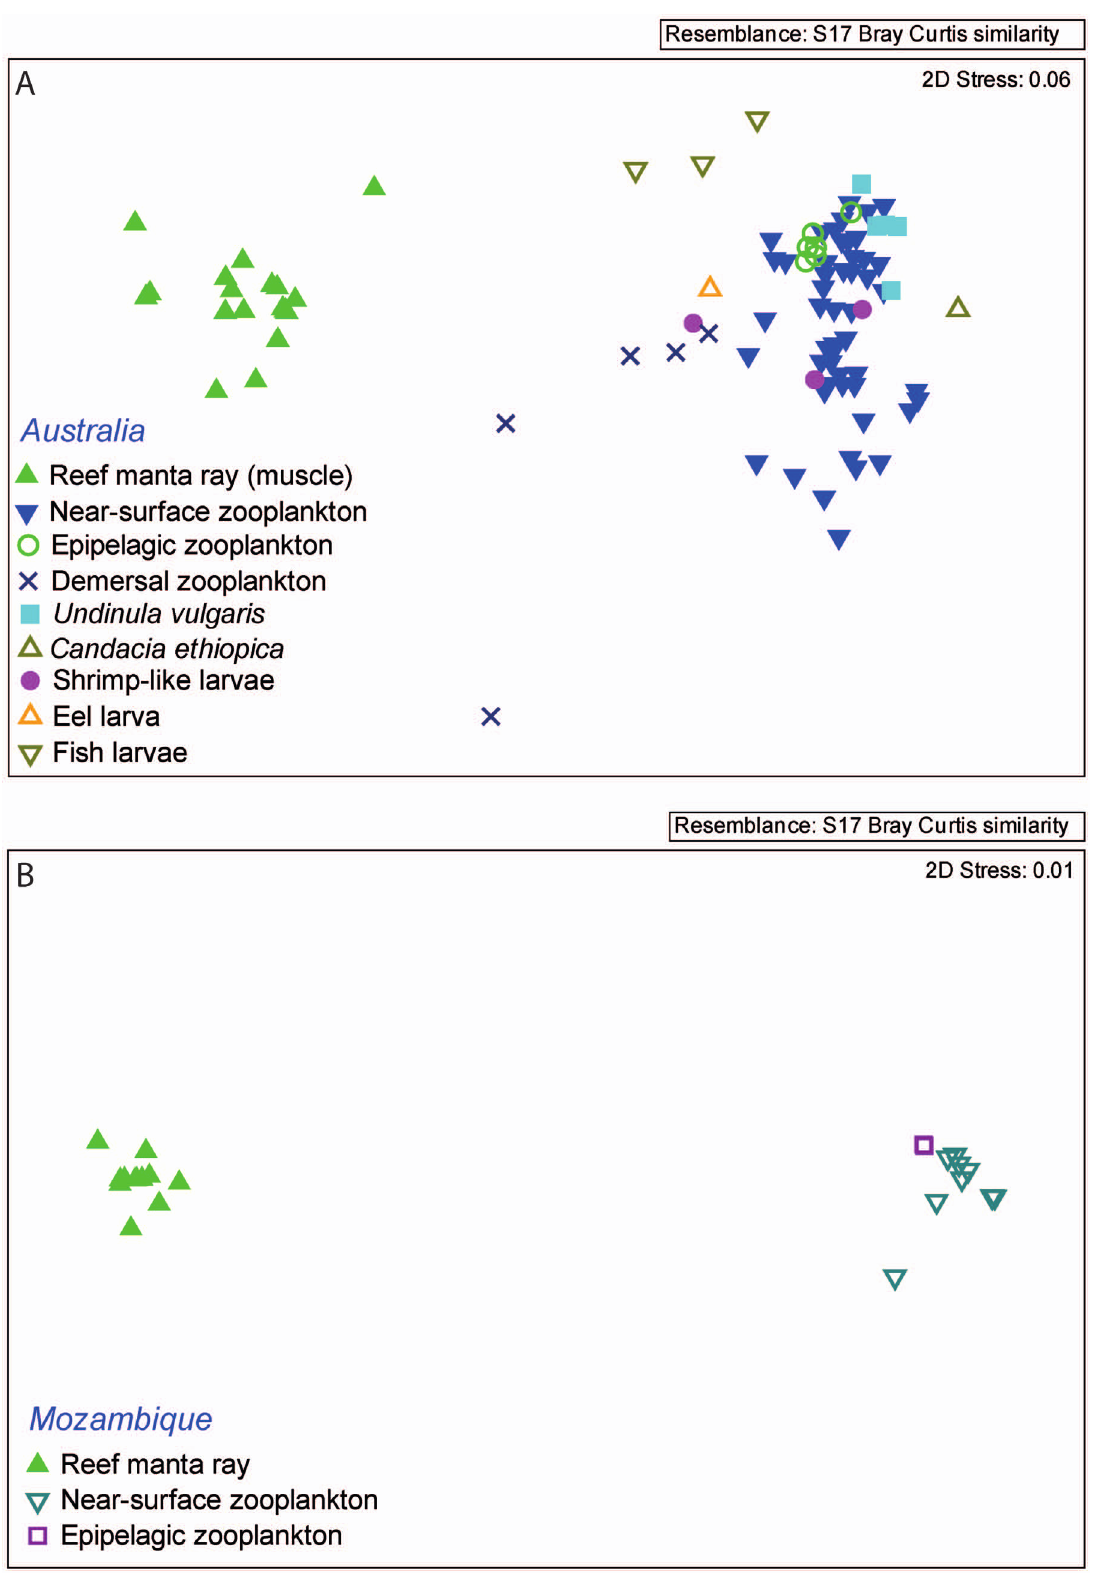
Figure 4. Comparison of reef manta ray tissue and zooplankton fatty acid (FA) profiles. Multi-dimensional scaling ordinations of (A) Australian reef manta ray muscle tissue and different zooplankton groups FA profiles collected off east Australia considering all FA . 1% (n=20), (B) Mozambican reef manta ray muscle tissue and different zooplankton groups collected off Mozambique considering all FA . 1% (n=20).